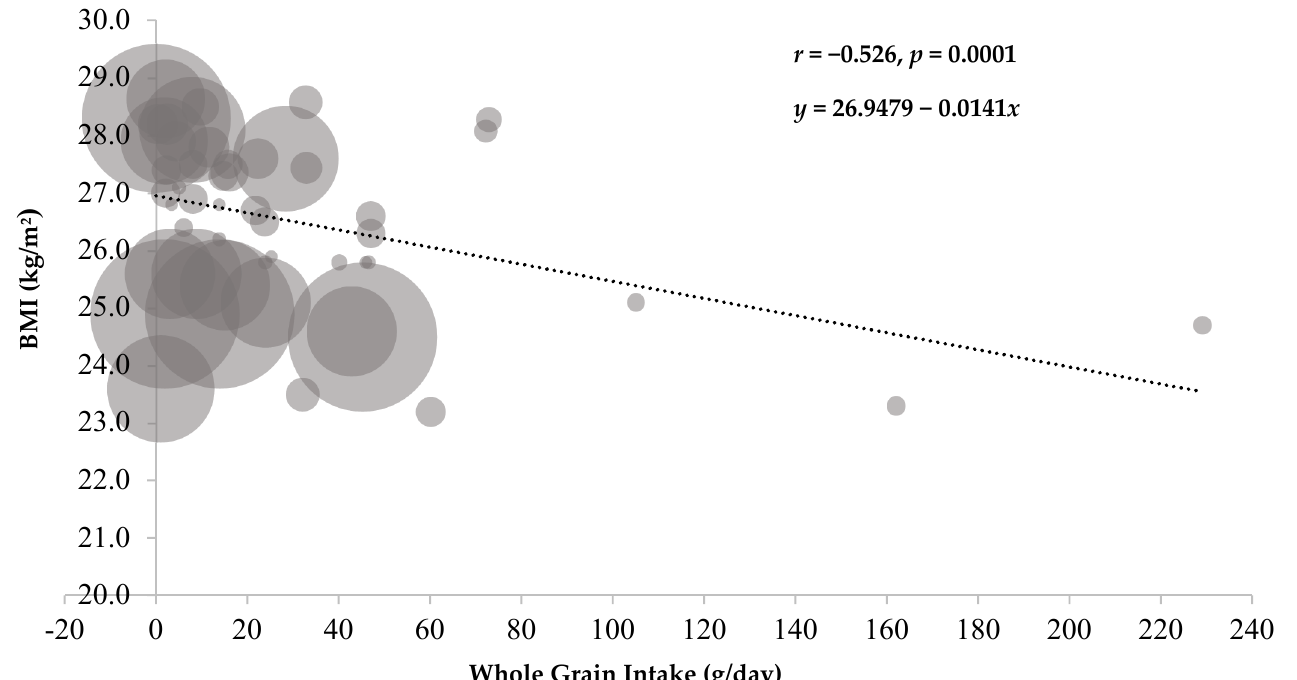
Figure 3. Weighted bubble plot of cross-sectional data from observational studies for the relationship between whole grain intake and body mass index (BMI) 1 . 1 For the unweighted analysis, the regression equation is y = 26.9211 – 0.0146 x ; r = − 0.406 ( p = 0.0034). Table 1. Outcomes summary of 6 cohort studies assessing the prospective association between WG intake and weight change 1 .